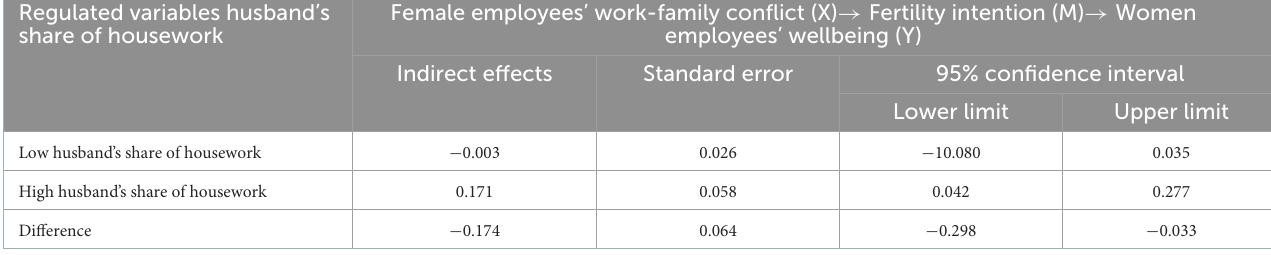
TABLE 6 Results of the test for mediating effects of being moderated at two stages (work-family conflict for female employees as independent variables). Regulated variables husband’s share of housework